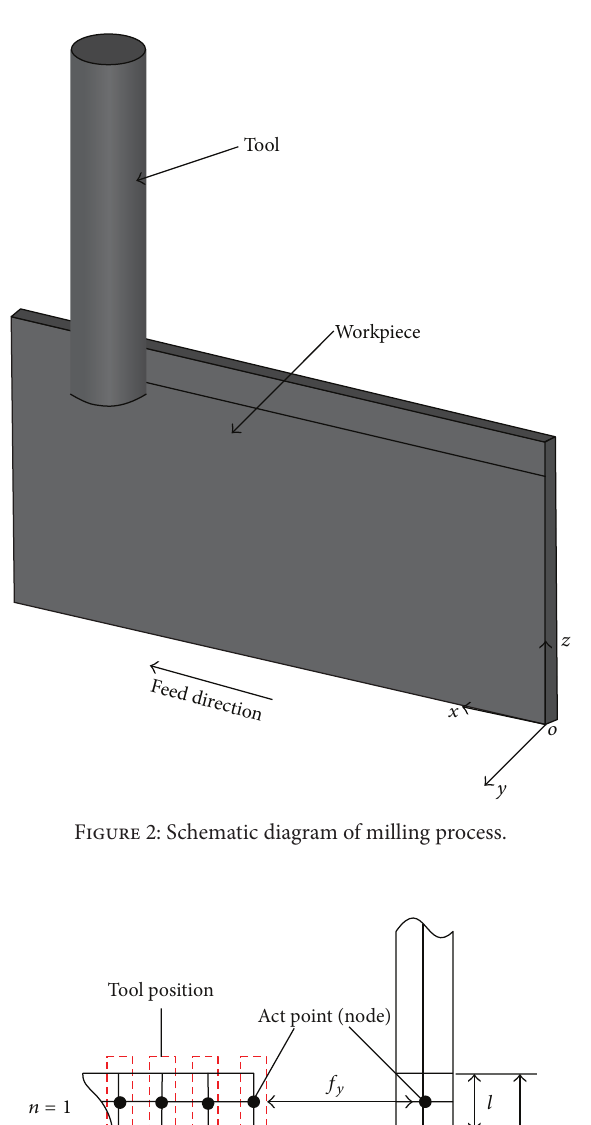
Figure 3: Loading locations of submilling forces.